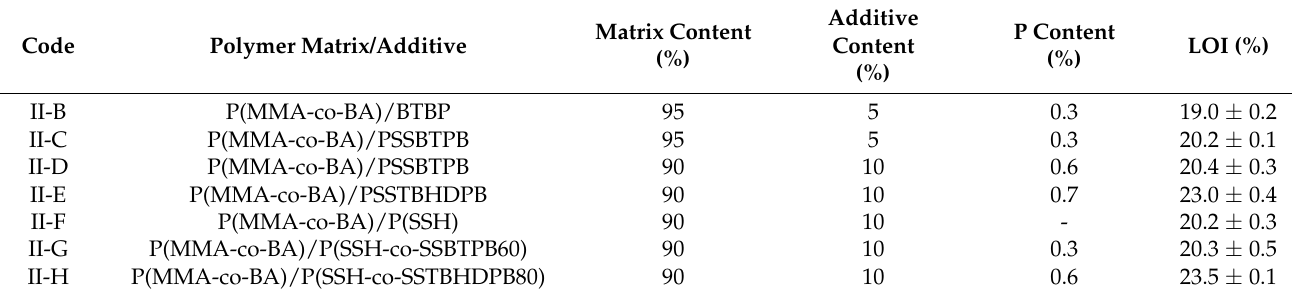
Table 3. LOI measurements of P(MMA-co-BA) blends.